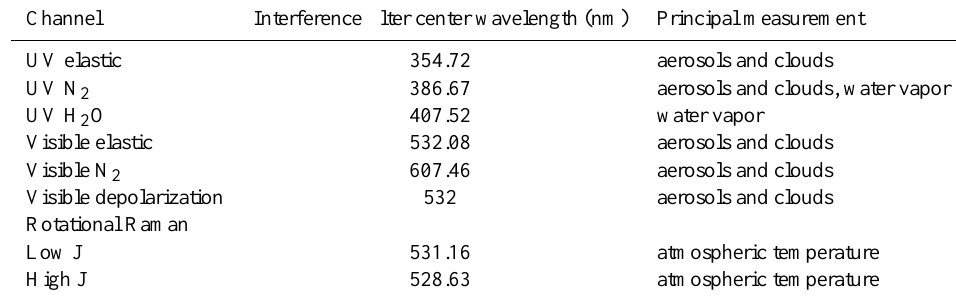
Table 1. CRL lidar receiver optical specifications. Based on Table 1 of Nott et al. (2012).